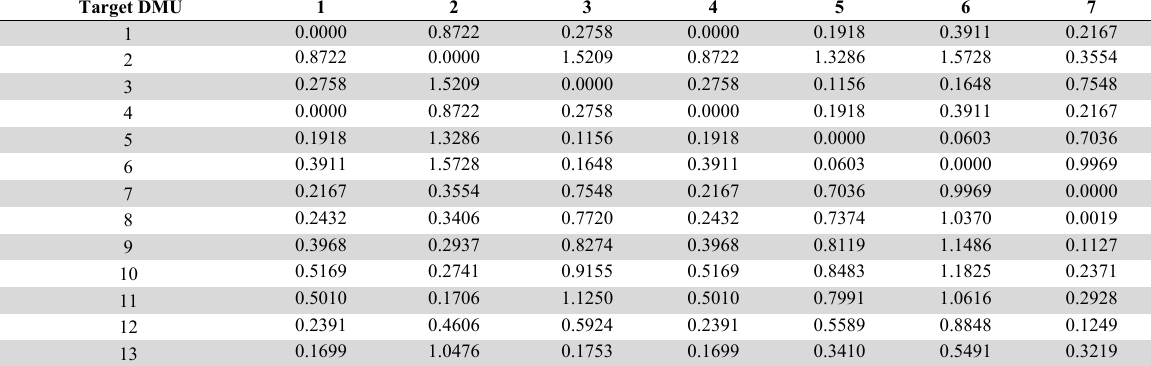
Criteria weights for fourteen international passenger airlines using the CRITIC